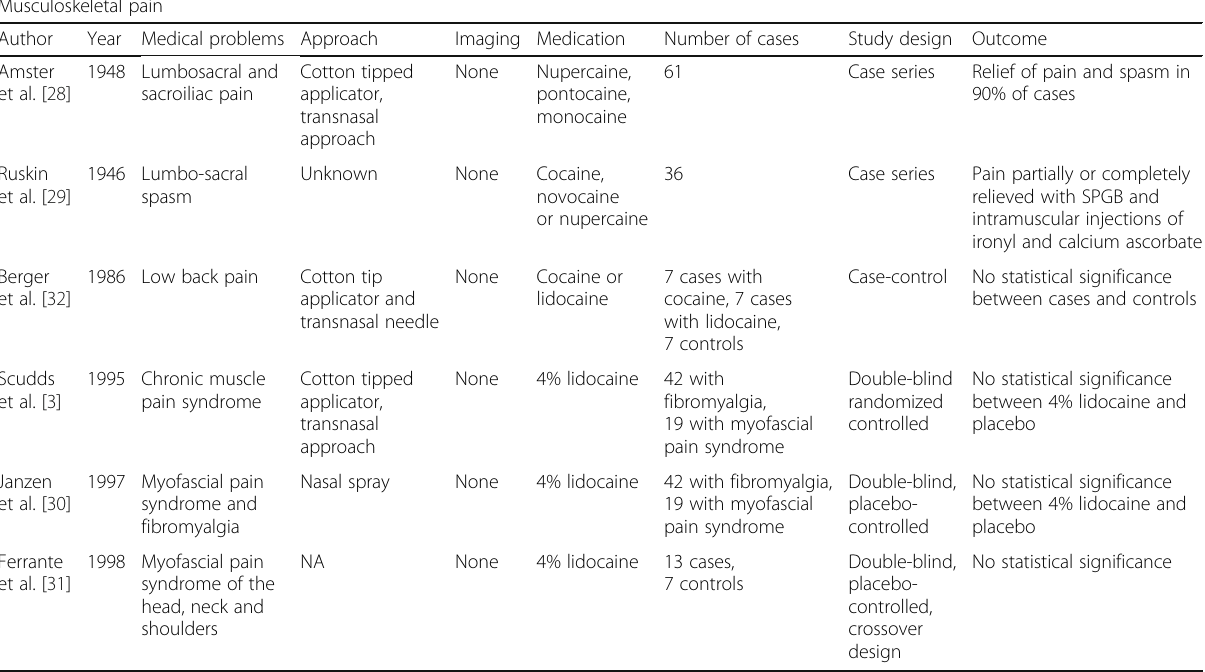
Table 9 Studies of SPG block for musculoskeletal pain Musculoskeletal pain